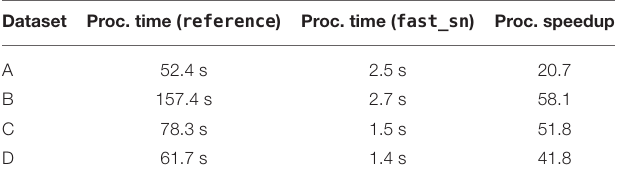
TABLE 2 | reference vs. fast_sn : processing and read time (in seconds) and fast_sn speedup.